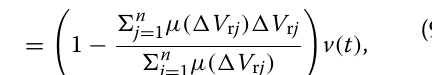
Interfering object linear